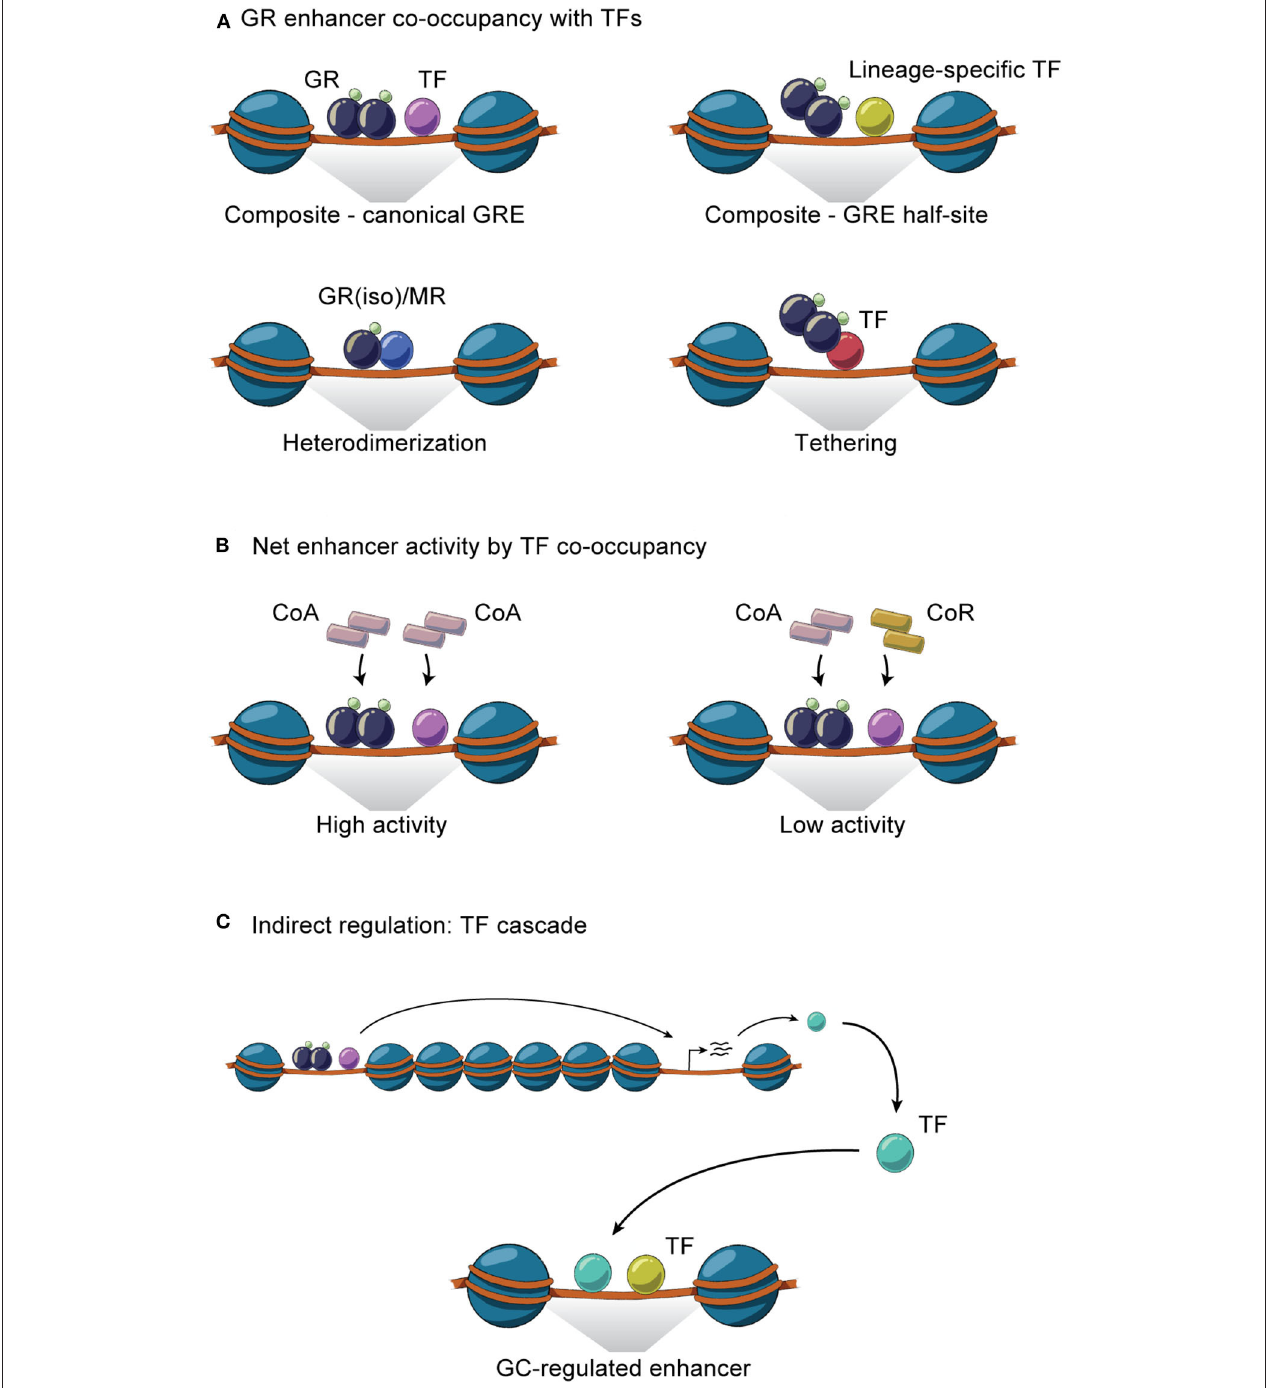
FIGURE 3 | GR interaction with TFs on chromatin. (A) GR and TFs co-occupy enhancers through homodimeric or monomeric GR binding together with TFs at composite sites, by heterodimerization and through tethering. (B) GR- and TF-mediated recruitment of coactivators (CoA) and/or corepressors (CoR) to co-occupied regulatory sites controls the net enhancer activity. (C) Indirect GR-TF interaction involves TF cascades, where the expression of GR regulates the expression of TF or vice versa. subset of sites via tethering to DNA-bound PPAR α to regulate hepatic Rev-erb α expression (115), demonstrating how GR and metabolic genes in the liver including Pdk4 (114). Moreover, GR the molecular circadian clock interconnect to regulate shared gene tethering to the BMAL1-CLOCK complex is suggested to repress